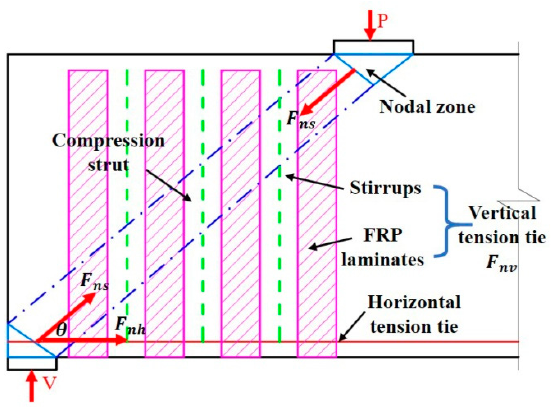
Figure 11. Strut-and-tie model for fiber reinforced polymer (FRP) laminates repair.